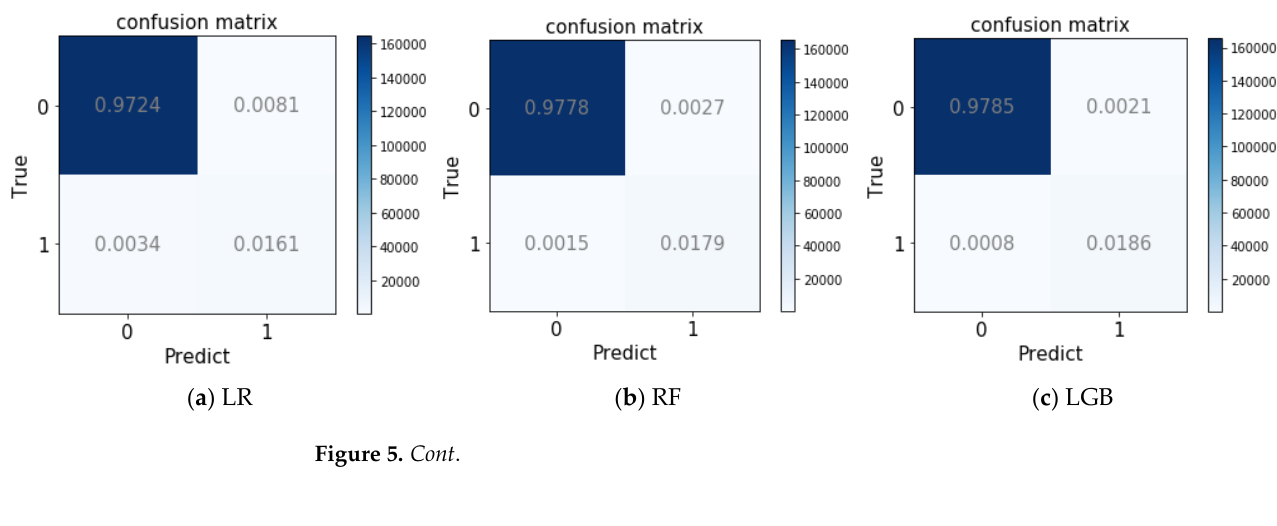
Figure 5 shows the confusion matrix for each model. It was tested on the edX dataset when K = 2 and train:test = 5:5. Figure 5a shows that the LR model obtained the maximum classification error with 0.0115. Figure 5f shows that ours obtained the minimum classification error with 0.0004, 0.0004 higher than the second minimum error produced by tri-training in Figure 5g.